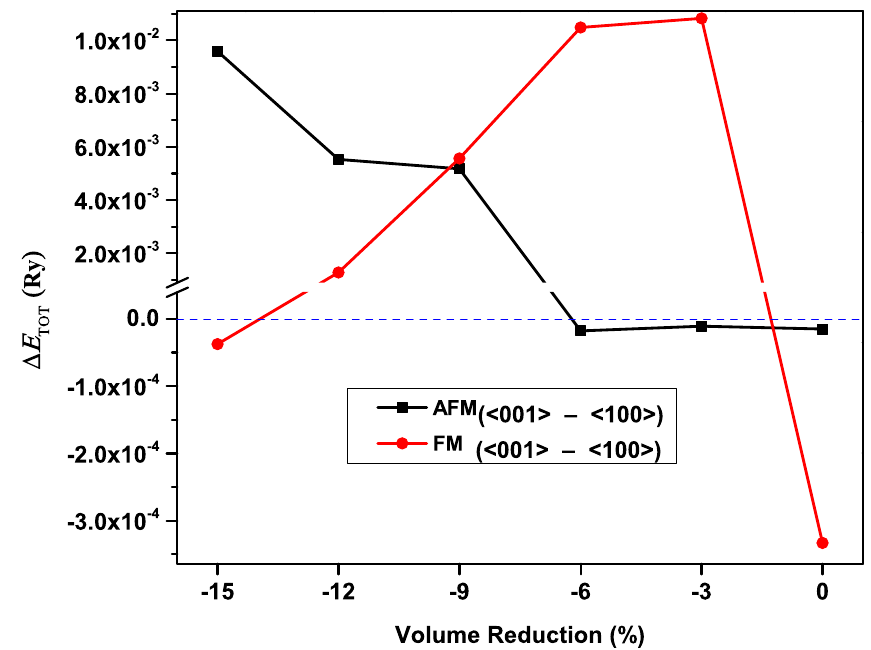
Figure 7. Pressure dependence of the ferromagnetic (FM) and antiferromagnetic (AFM) states of the CeAgSb 2 compound with different orientations of the magnetization, one with the magnetization along the < 001 > direction and the other along the < 100 >